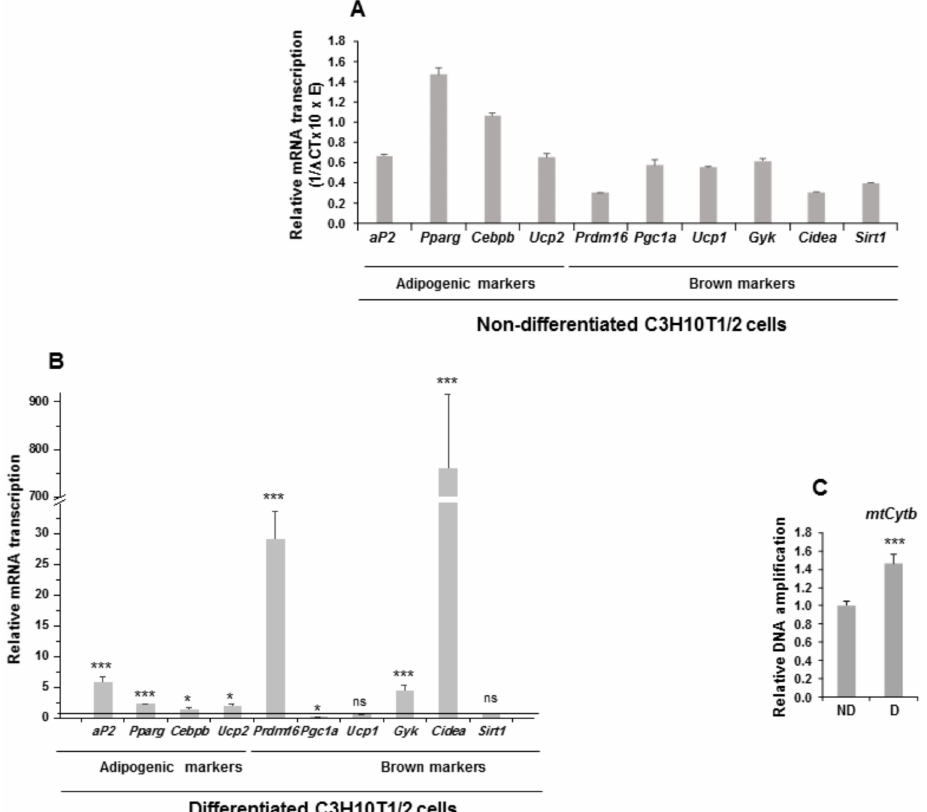
Figure 3. Expression of adipogenic markers and mitochondrial biogenesis markers in non-di ff erentiated and di ff erentiated C3H10T1 / 2 cells. ( A ) Relative mRNA transcription levels (1 / ∆ C T (cycle threshold) × 10 × E (oligonucleotide e ffi ciency)) of the adipogenic and brown adipocyte markers aP2 (adipocyte protein 2 / fatty acid binding protein 4), Pparg (peroxisome proliferator activated receptor gamma), Cebpb (CCAAT Enhancer Binding Protein Beta), Ucp2 (uncoupling protein 2), Prdm16 (PR domain-containing 16), Pgc1a (peroxisome proliferator activated receptor gamma coactivator 1-alpha), Ucp1 (mitochondrial uncoupling protein 1) , Gyk (glycerol kinase), Cidea (cell death-inducing DNA fragmentation factor, alpha subunit-like e ff ector A), and Sirt1 (Sirtuin 1) in non-di ff erentiated C3H10T1 / 2 cells. ( B ) Relative mRNA transcription levels of the same adipogenic and brown adipocyte markers in seven-day di ff erentiated C3H10T1 / 2 cells. ( C ) qPCR analysis of mitochondrial Cytb DNA amplification (related to genomic